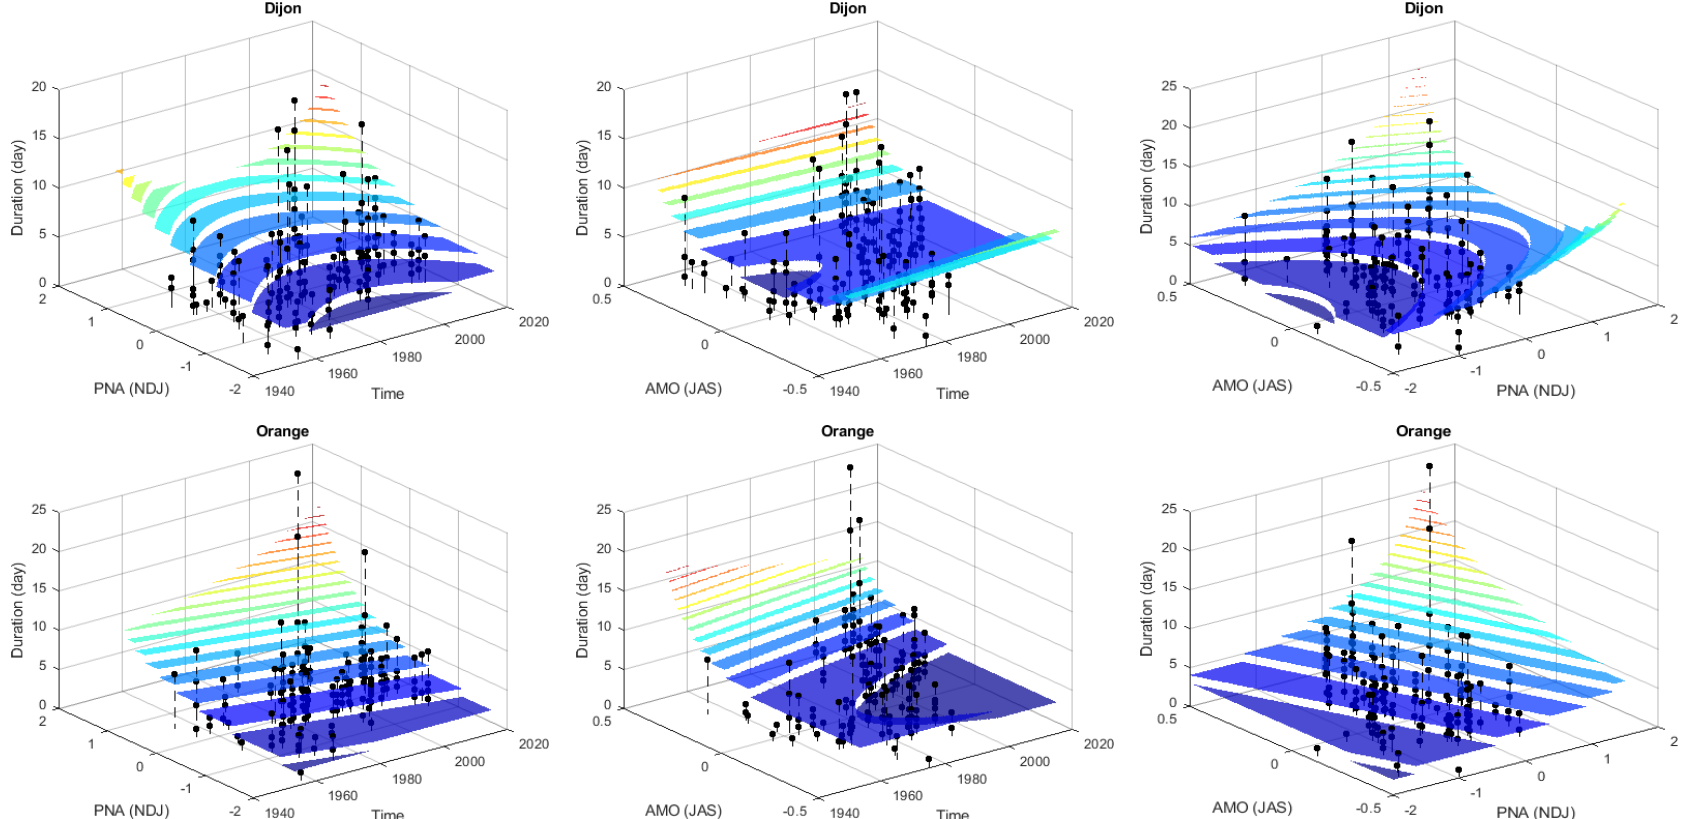
Figure 11. Duration quantiles corresponding to the non-exceedance probability p = 0.9 as a function of the combination of two covariates.